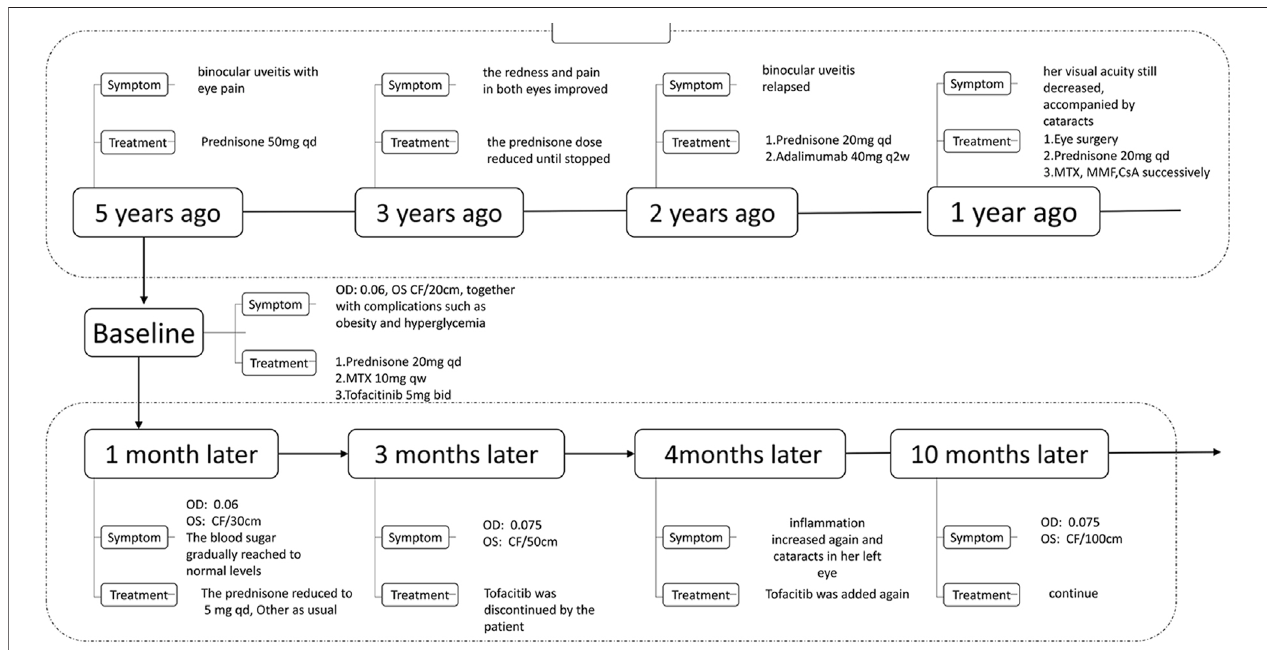
FIGURE 1 | Treatment